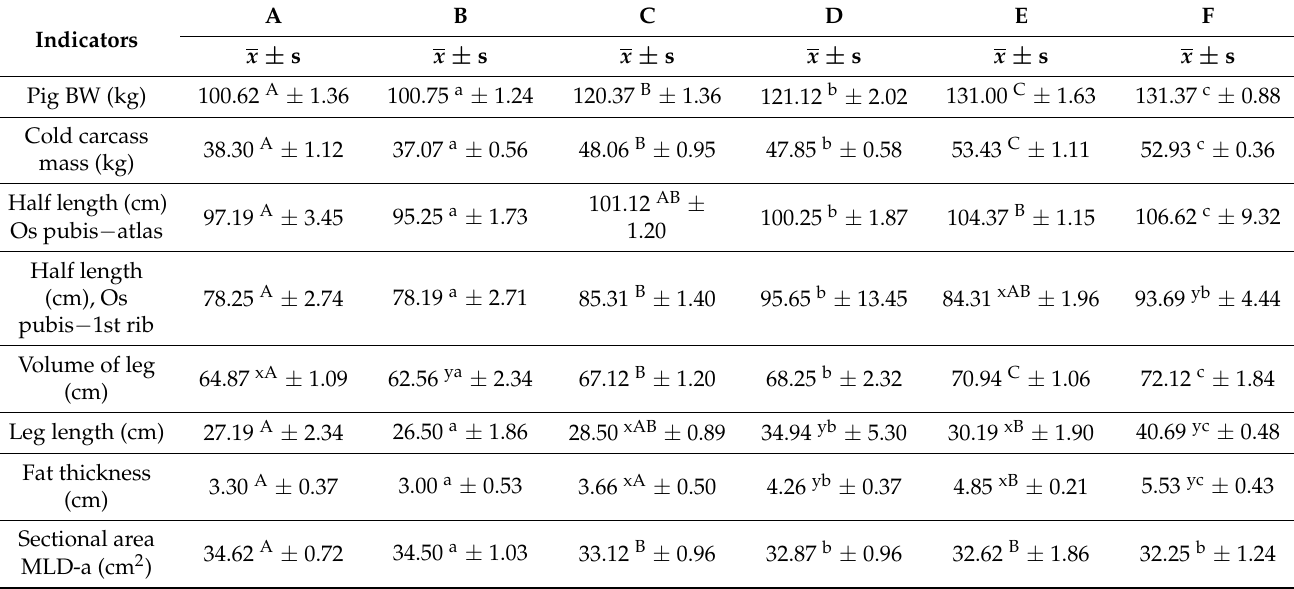
Table 2. Basic indicators of the quality of pig